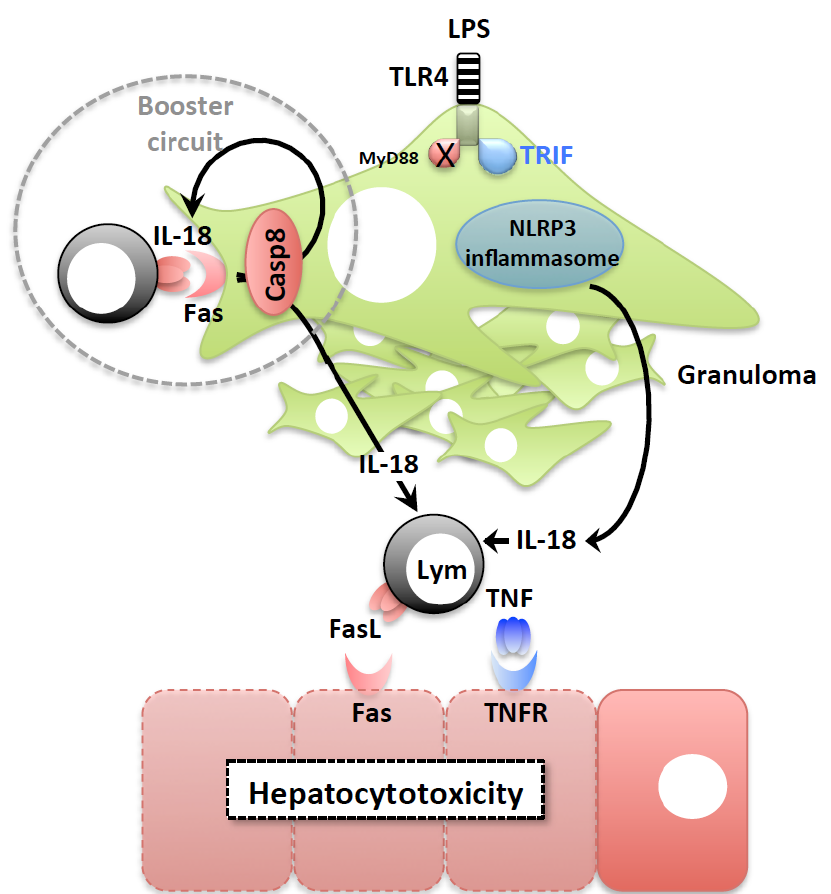
Figure 3. TLR4-TRIF-NLRP3 inflammasome-IL-18 axis for lipopolysaccharide (LPS)-induced liver injury. After LPS challenge, the TLR4-TRIF-mediated signal is transduced in the P. acnes -elicited hepatic macrophages to activate the NLRP3 inflammasome, in which precursor caspase-1 becomes enzymatically active caspase-1. Caspase-1 then cleaves precursor IL-18 to secrete mature IL-18. IL-18 activates lymphocytes such as neutral killer cells to express Fas ligand (FasL) and produce tumor necrosis factor- α (TNF). Both FasL and TNF induce apoptotic hepatocyte cell death. P. acnes -elicited hepatic macrophages express Fas. Upon FasL stimulation, P. acnes -elicited hepatic macrophages produce mature IL-18 in a caspase-8-dependent manner. Thus, IL-18-induced FasL expression and Fas-mediated caspase-8-dependent IL-18 release serve as the booster